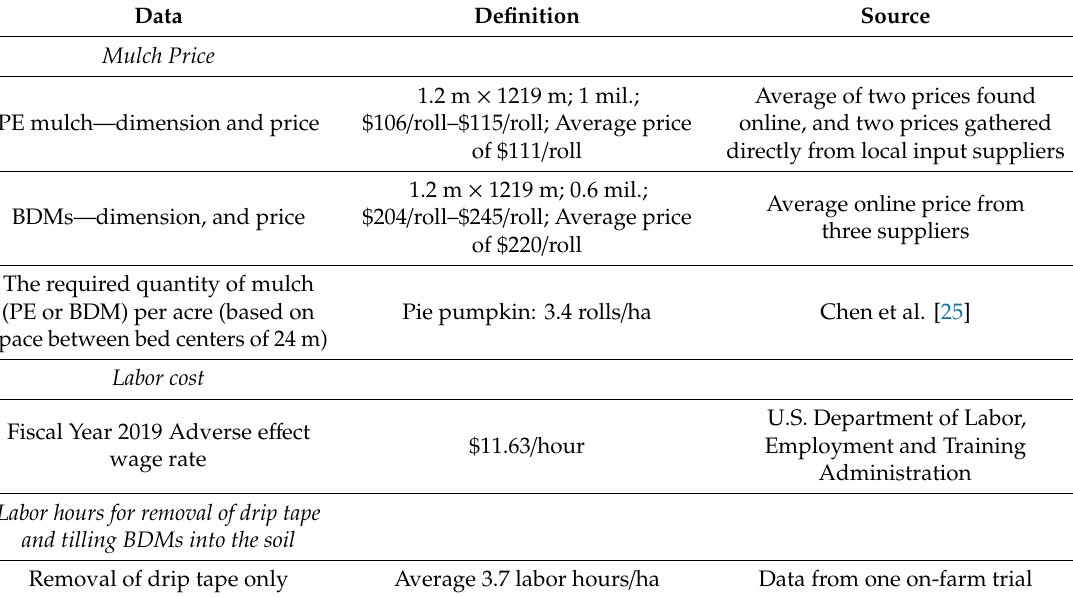
Table 4. Secondary data used in the partial budget